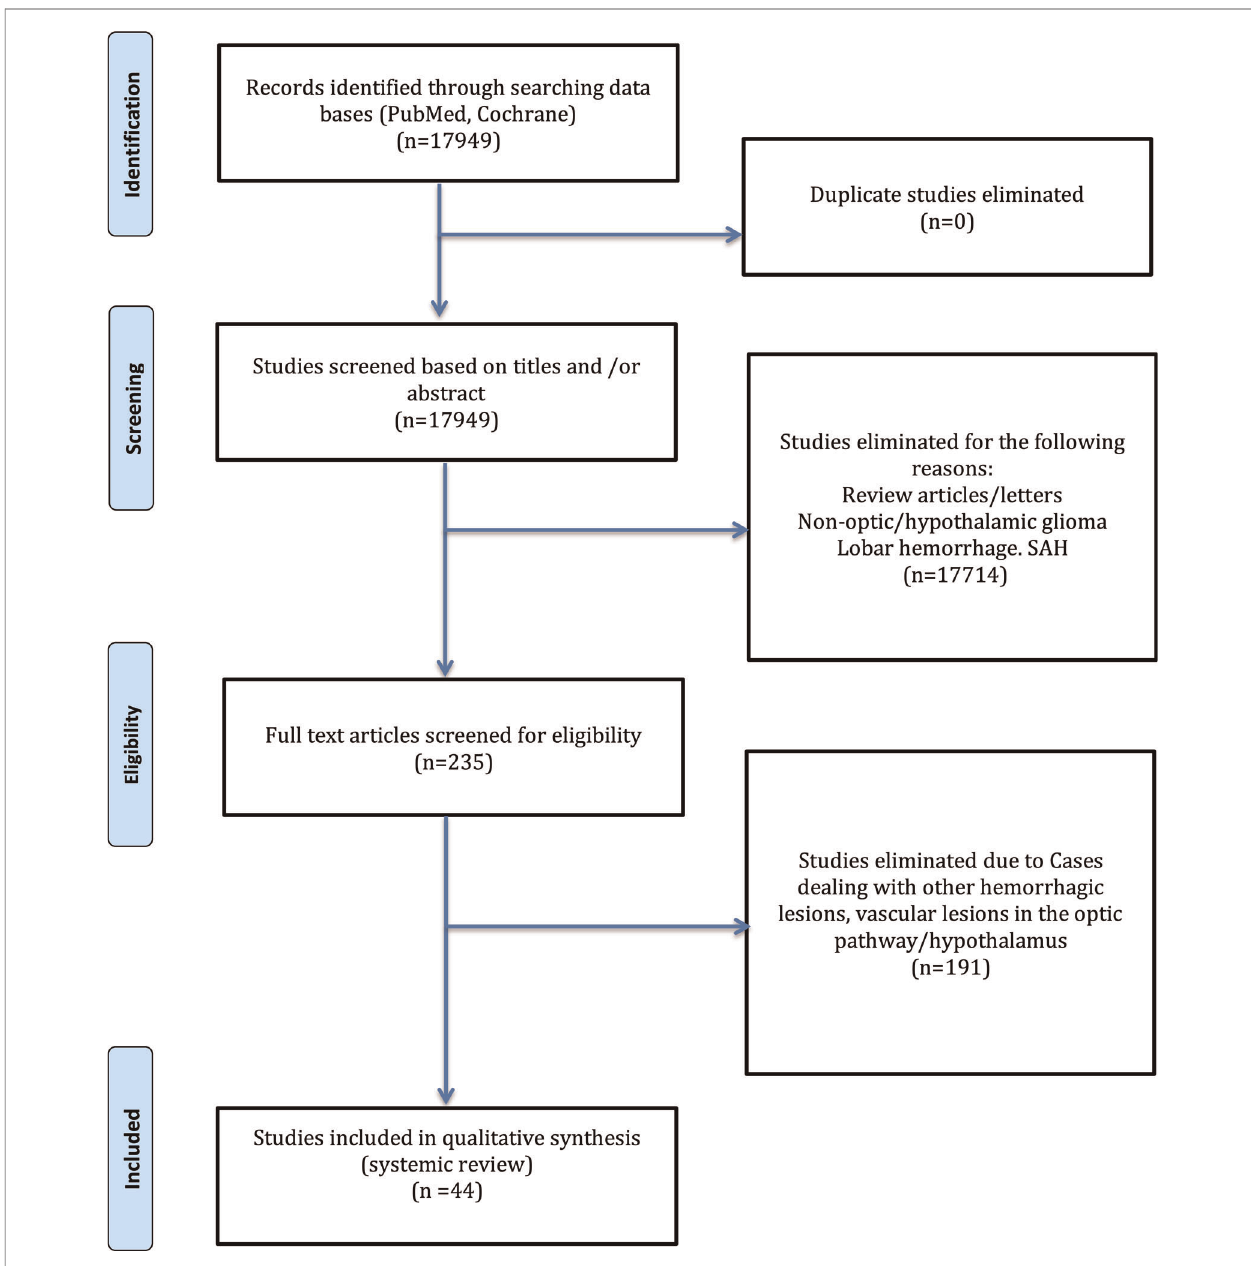
FIGURE 9 | PRISMA fl owchart of the review